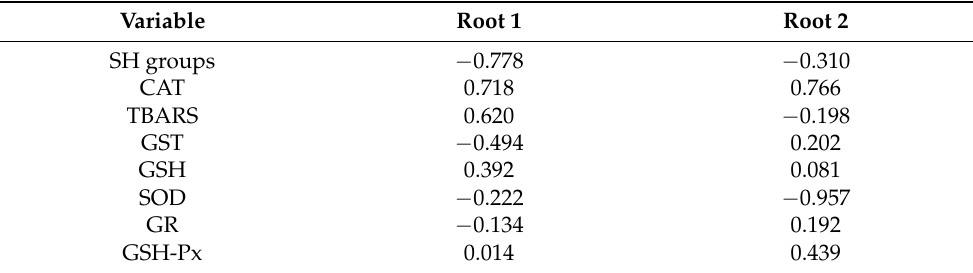
Table 3. Standardized coefficient for canonical variables (oxidative stress